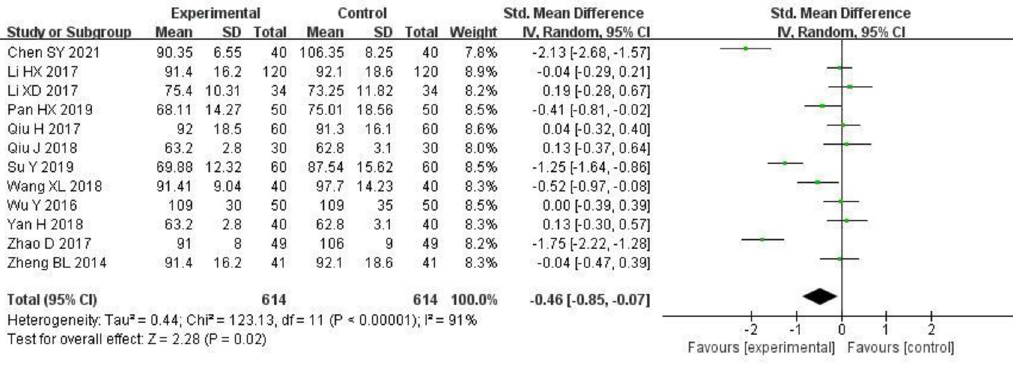
Fig 5. Forest plot of effects of Shenyankangfu tablets and Losartan potassium in the treatment of chronic glomerulonephritis on Serum creatinine.